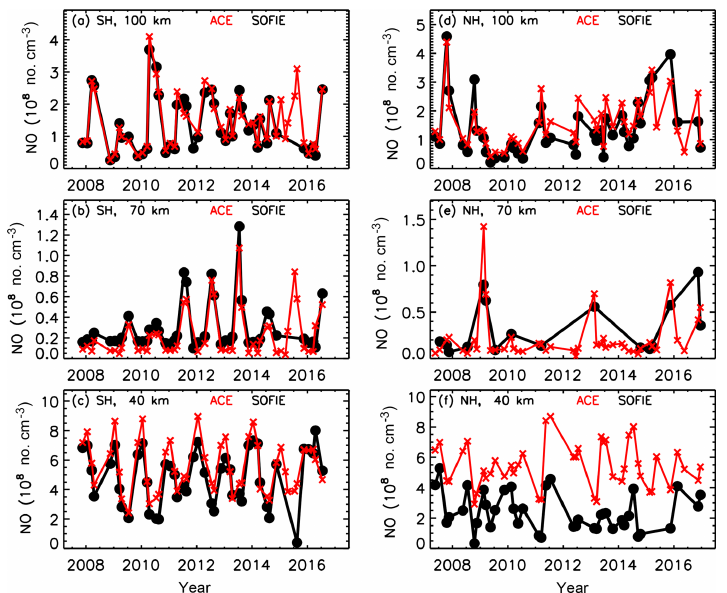
Figure 10. Comparison of SOFIE and ACE NO time series as monthly zonal means, for the coincidences shown in Fig. 5. SH results are shown for (a) 100km, (b) 70km, and (c) 40km altitude. NH results are shown for (d) 100km, (e) 70km, and (f) 40km altitude.